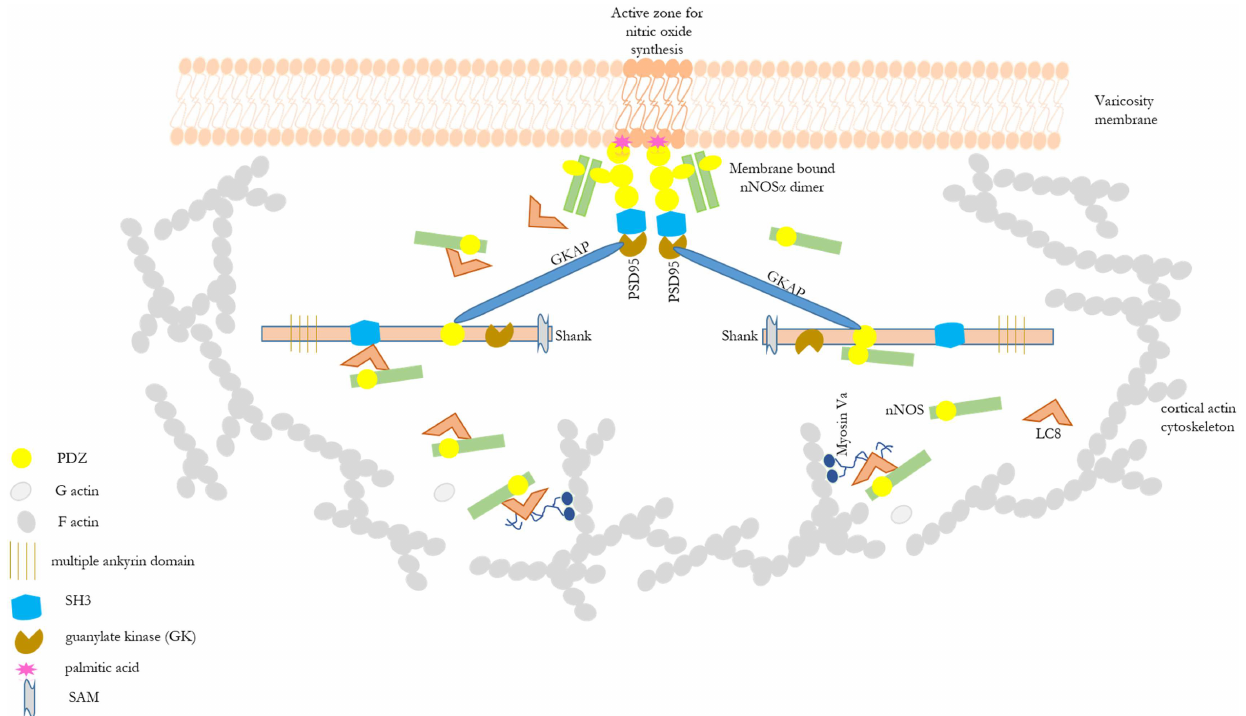
FIGURE 2 | Cartoon depicting possible role of shank in shuttling of cytosolic nNOS to the nitrergic nerve terminal membrane .This depicts the basis of the hypothesis of possible role of shank in nitrergic neurotransmission. Different scaffolding proteins are shown with the modular domains without appropriate scale to the full length of the proteins. Details of these modular domains are described in Kim and Sheng (57). nNOS, via interaction with LC8 or PDZ-domain-based interaction, may be shuttled from acto-myosinVa in the cytosol through